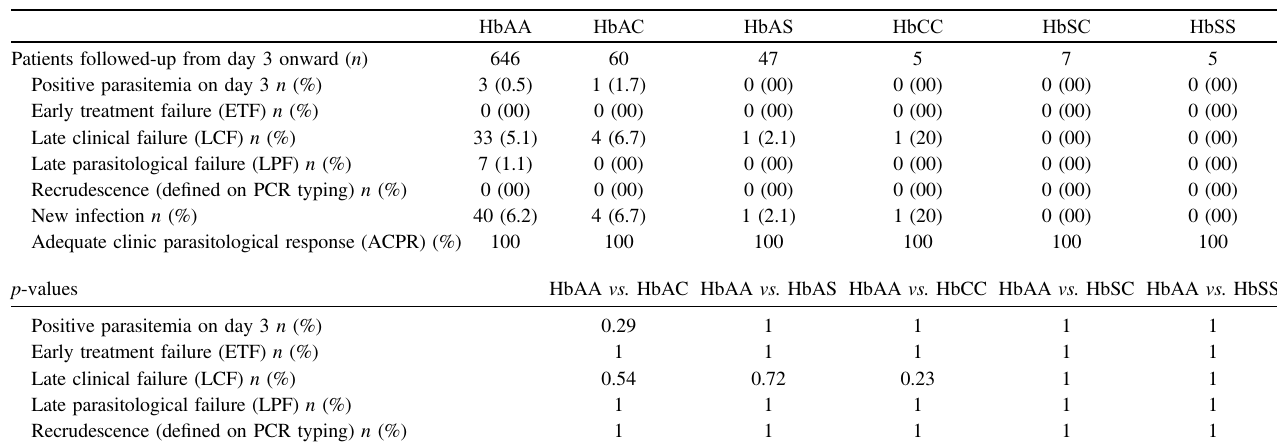
Table 3. Characteristics of patients during follow-up according to hemoglobin type. HbAA HbAC HbAS HbCC HbSC